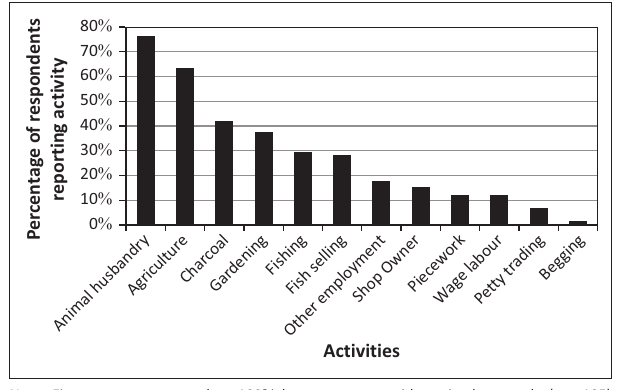
FIGURE 3: Livelihoods activities in Kasaya.